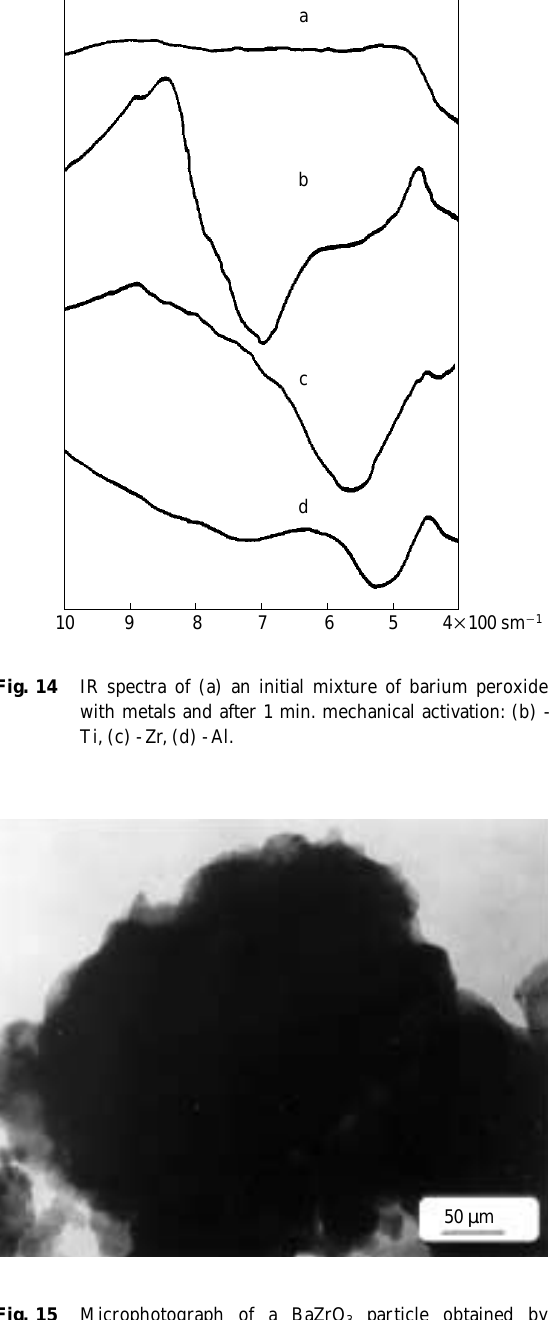
Fig. 15 Microphotograph of a BaZrO 3 particle obtained by mechanochemical synthesis during 1